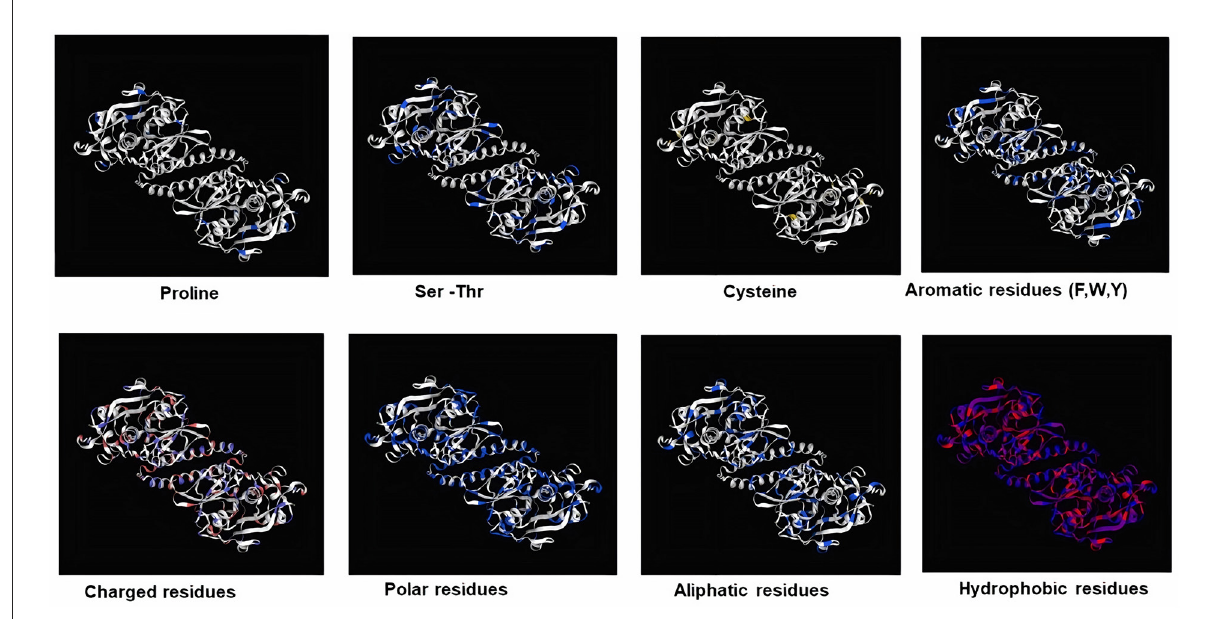
FIGURE4 Mapping of different structure of amino acid residues in 3D structure model of FhCatL1 (https://swissmodel.expasy.org/).